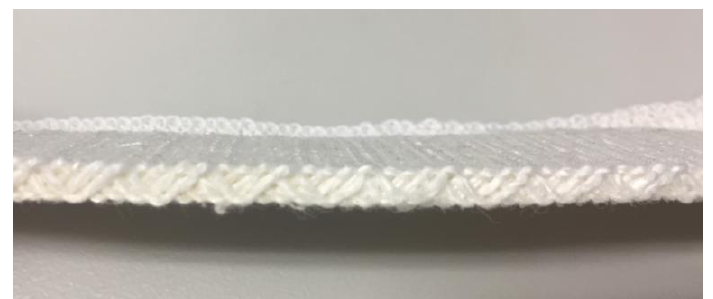
Figure 3. Photograph of a typical fabricated spacer fabric.